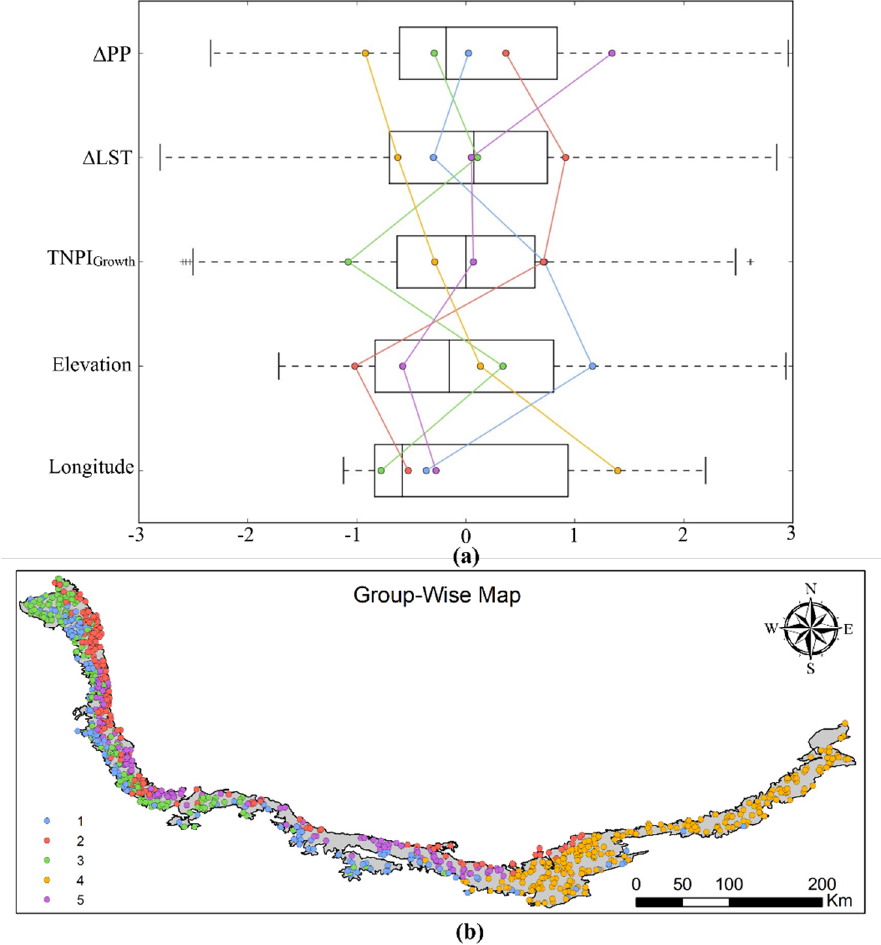
Figure 5. Grouping analysis of five vegetation growth-environmental factor groups consisting of a ( a ) box plot for MODIS-derived TNPI Growth and environmental factors along the longitudinal direc- tion (from west to east), and ( b ) corresponding clusters of each group shown in the map. The whiskers of the plot show the spread of the variable, with the left whisker being the lowest value and the right whisker being the highest value.